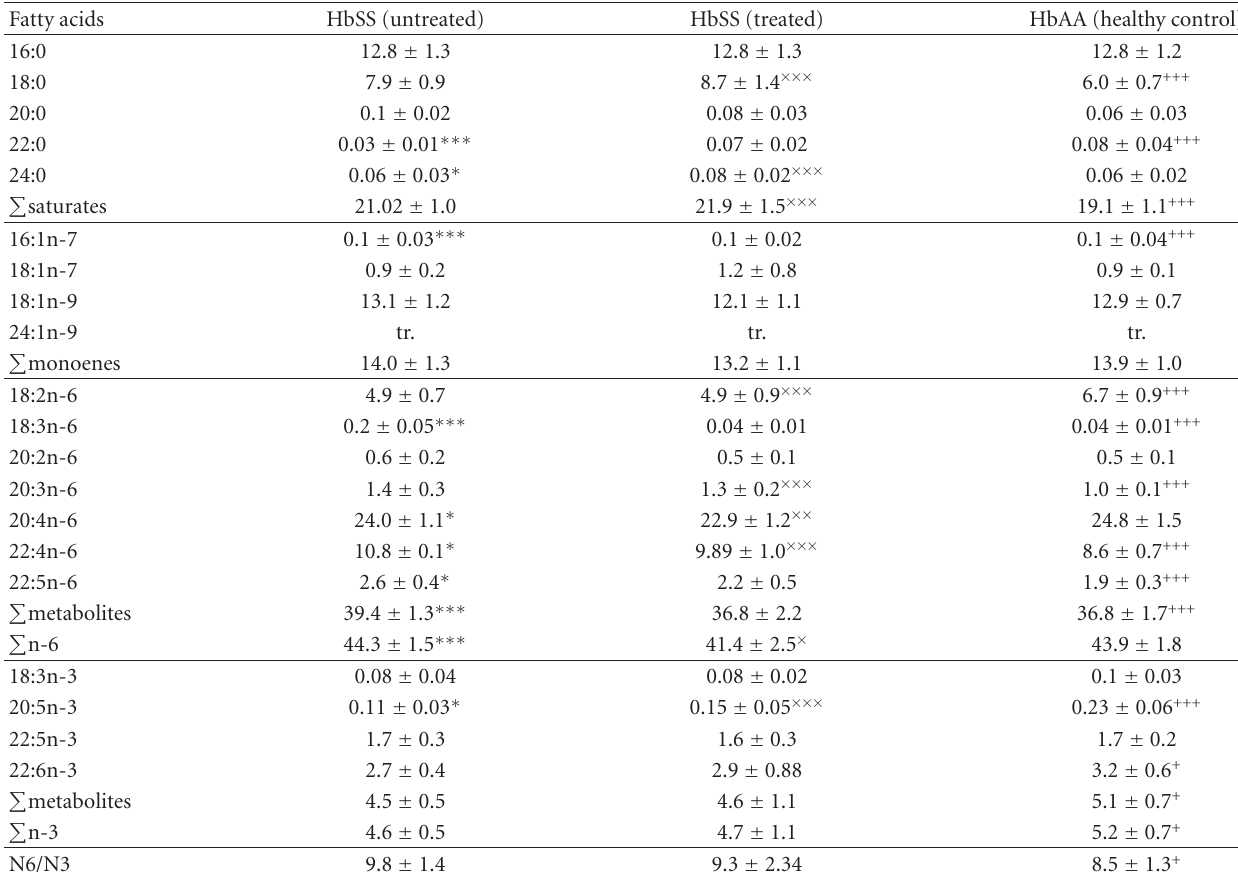
Table 5: Fatty acid composition of red blood cell ethanolamine phosphoglycerides of HU-untreated ( n = 17) and treated ( n = 19) HbSS sickle cell patients and HbAA healthy controls ( n =